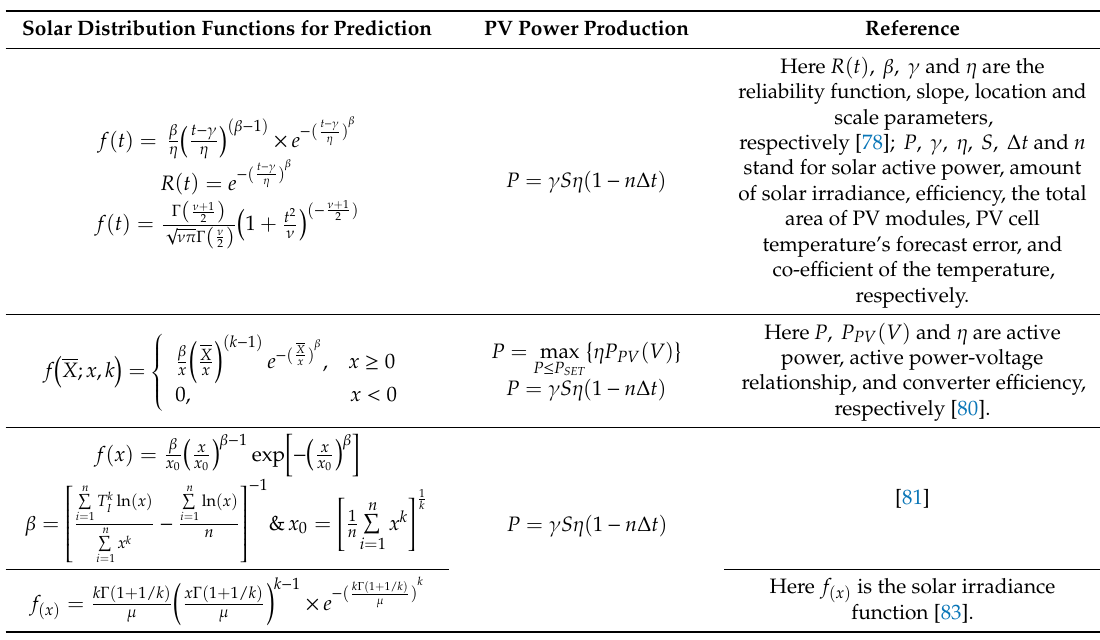
Table 4. Solar prediction with WD and without incorporation of